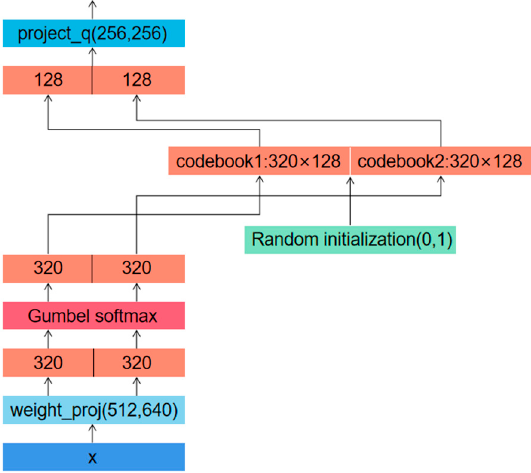
Figure 6. Illustrates the calculation flow inside the quantization module.